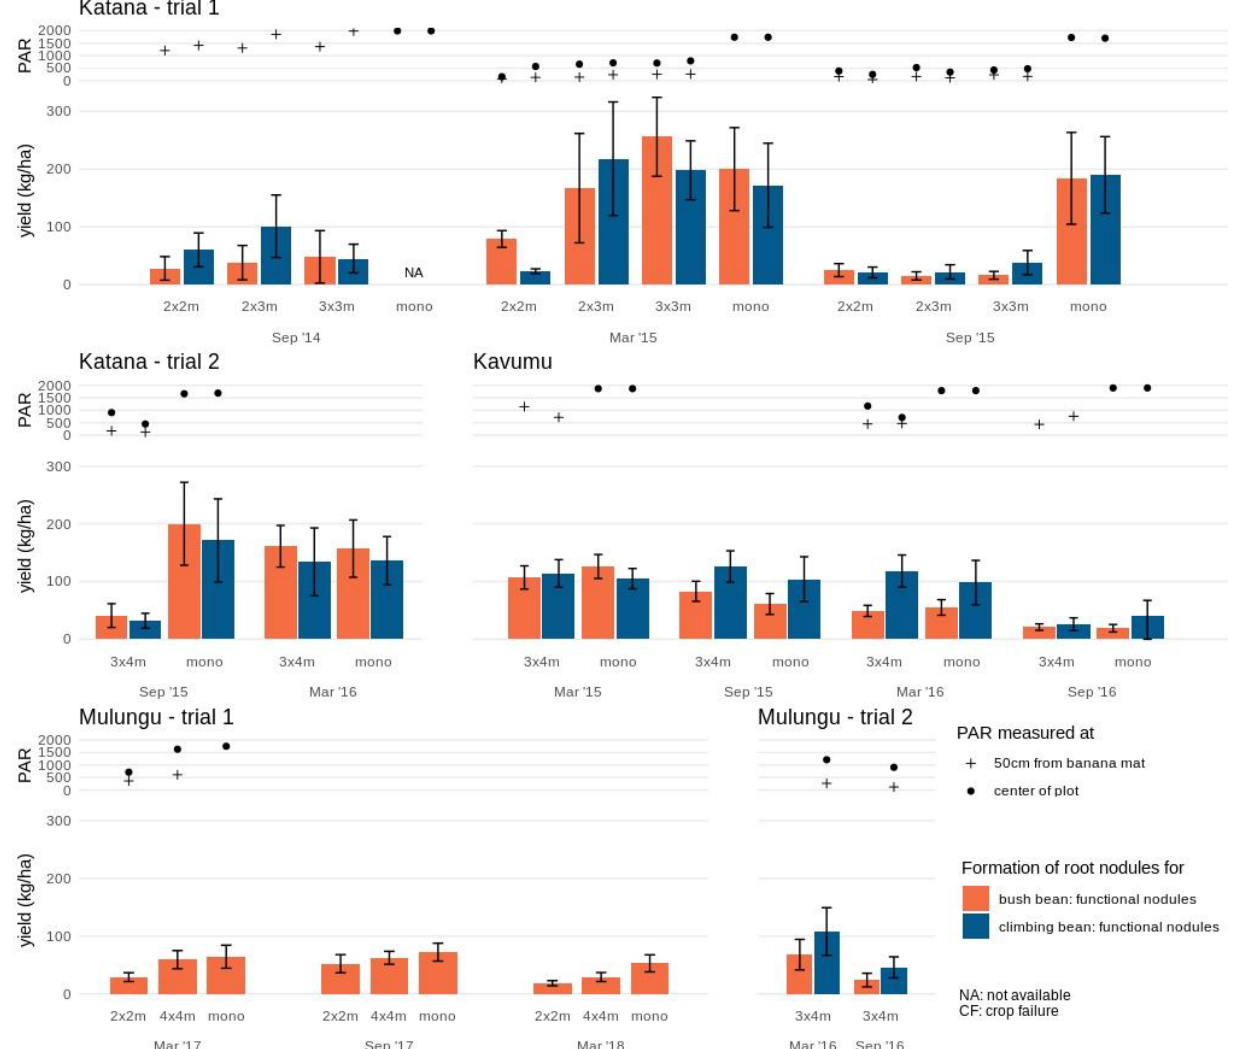
Figure 2. Root nodule formation of bush bean and climbing bean in various intercrop formations and monocrops at the study sites Katana, Kavumu and Mulungu. Functional nodules are indicated separately for bush bean (orange) and climbing bean (blue) at each intercrop formation and cropping season. The annual crop in monocrop formation is not assessed (NA) at Katana in September 2014 and not available in trial 2 at Mulungu. Photosynthetic active radiation (PAR) measured at the center of the plot (full circle) and 50 cm from the banana mat (cross) is indicated for each annual intercrop and monocrop. Note that during some stages of the experimental trial PAR measurements are not available due to temporary equipment defects.